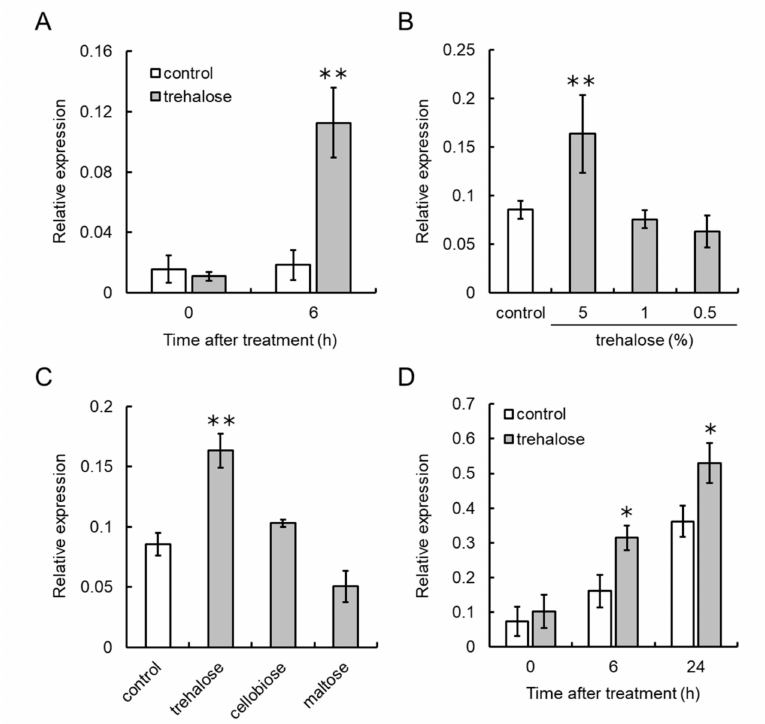
Figure 4. Exogenous trehalose upregulates VvCKX5 gene expression in VR cells and juvenile grape inflorescences. ( A ) Transcription of VvCKX5 in VR cells treated with 5% trehalose. ( B ) Transcription of VvCKX5 in VR cells treated with 0.5, 1%, and 5% trehalose at 6 h post treatment. ( C ) Transcription of VvCKX5 in VR cells treated with 5% of each disaccharide at 6 h post treatment. ( D ) Transcription of VvCKX5 in juvenile grape inflorescences treated with 5% trehalose. VR cells and juvenile inflorescences from field-grown grapevines were treated with trehalose or other disaccharides. Total RNA was isolated from VR cells and inflorescences and subjected to real-time RT-PCR. Actin was used as an internal control. Data were calculated as gene expression level relative to actin gene expression level. Bars indicate means ± standard deviations of five independent experiments. * p < 0.05 compared with control (Student’s t -test for D). ** p < 0.01 compared with control (Student’s t -test for A or Dunnett’s test for B and C). Control, no